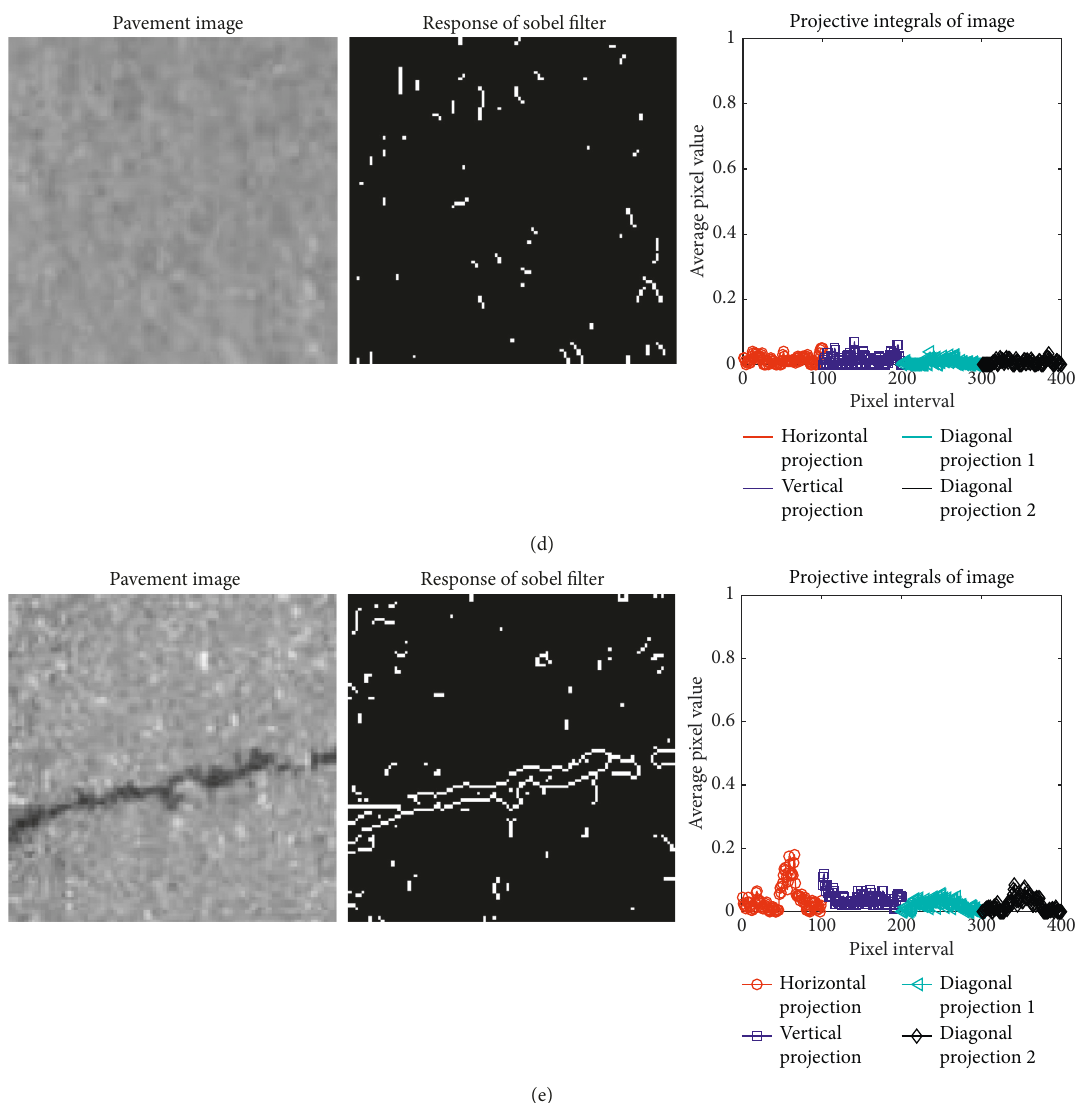
Figure 10: Projection integrals of asphalt pavement images using SBF response: (a) alligator crack; (b) diagonal crack; (c) longitudinal crack; (d) noncrack; (e) transverse